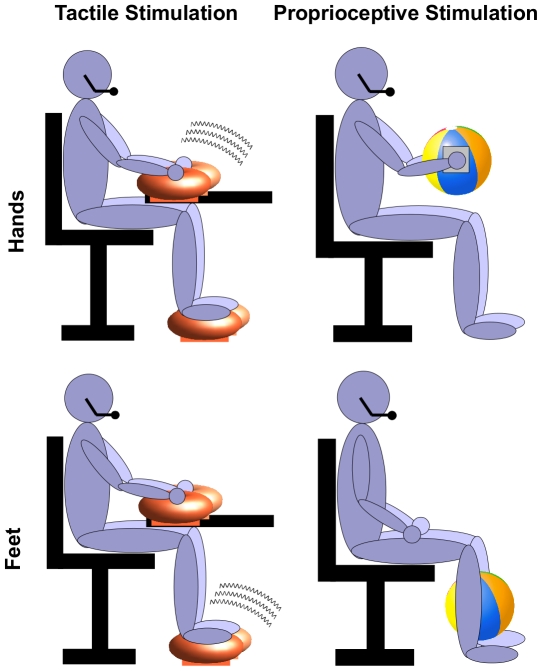
Schematic of perceptual stimulation to the hands (critical condition) or feet (control condition), showing participant receiving tactile stimulation from vibrating cushions, or proprioceptive stimulation from holding a 30 cm diameter beachball.